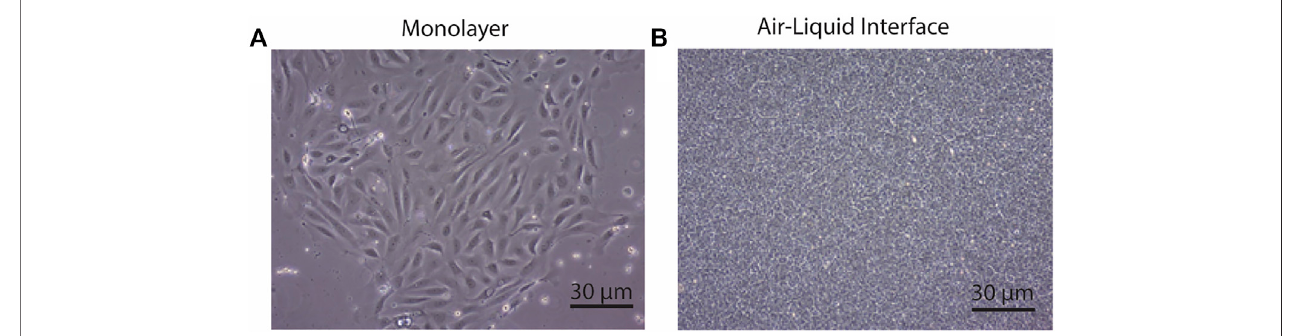
FIGURE 3| Cftr Δ 9/ Δ 9deleted airway epithelial cell morphology. (A) . Airway epithelial cells grown in monolayer had standard cobble stone appearance.Scale bar: 30 micrometres (B). Airway epithelial cells grown at the air-liquid interface with the dense packed growth morphology. Scale bar 30 micrometres. n = 4.